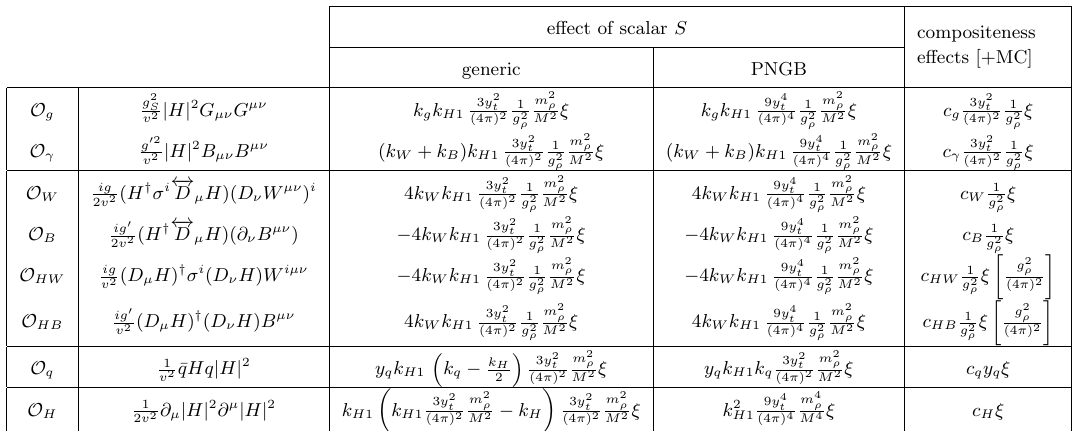
Table 2 . Contributions of a generic or PNGB scalar S to the dimension-six operators in the SILH basis, together with the contributions coming from the generic strong dynamics. Coe(cid:14)cients for the inert scalar can be obtained by multiplying with additional loop factors, as described in the text. (cid:27) i are Pauli matrices. c i are order-one coe(cid:14)cients. The loop suppression factors in square brackets apply if we impose MC on the Higgs sector. Except for the two operators the e(cid:11)ects of S can potentially dominate over the other strong sector e(cid:11)ects if S is su(cid:14)ciently light and g (cid:26) su(cid:14)ciently